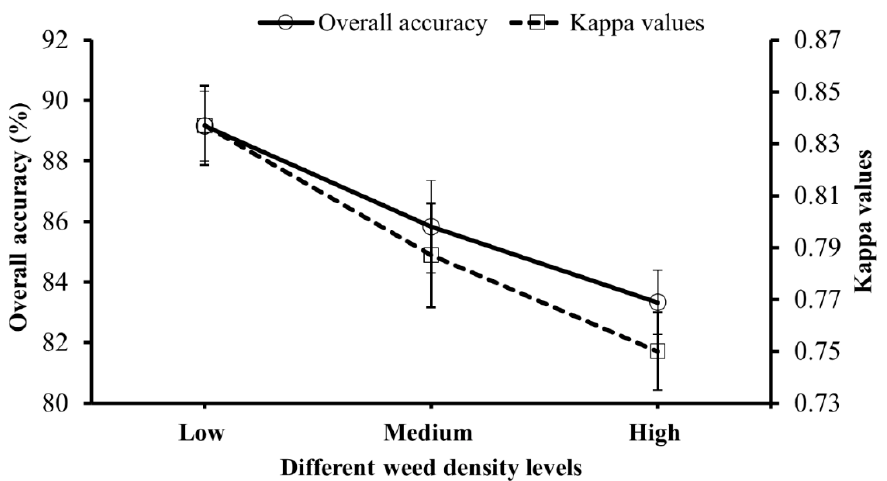
Figure 5. Accuracy measures for various levels (low, medium, and high) of weed densities established in the experiment.